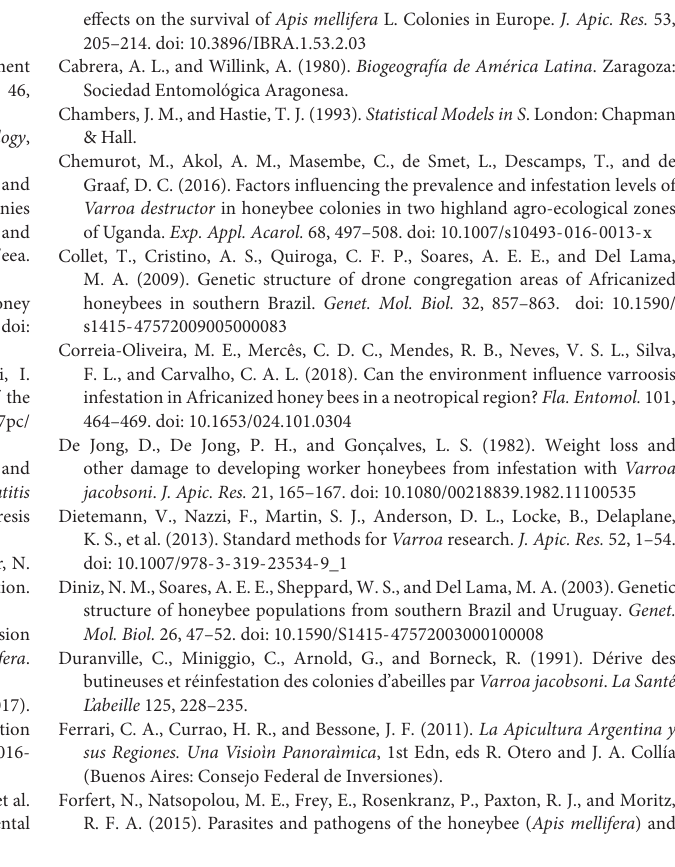
Supplementary Figure 1 | Percentage of mitochondrial lineages of drones at the Drone Congregation Areas and workers at the nearest apiaries for the sites at Buenos Aires. African-derived (A1, A4) and European-derived lineages (C1, C2j) are shown in orange and blue, respectively. Numbers of analyzed bees are shown between brackets. Supplementary Figure 2 | Percentage of mitochondrial lineages of drones at the Drone Congregation Areas and workers at the nearest apiaries for the sites at Tucumán. African-derived (A1, A4) and European-derived lineages (C1, C2j) are shown in orange and blue, respectively. Numbers of analyzed bees are shown between